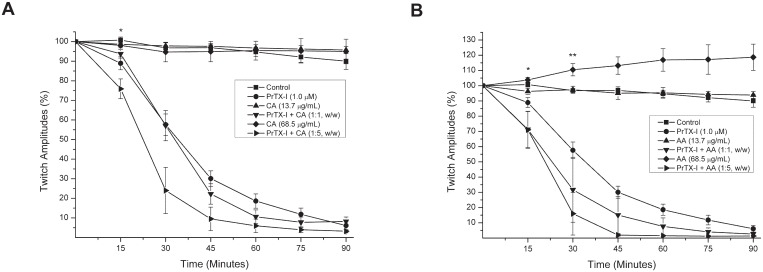
Effects of PrTX-I and PrTX-I pre-incubated with caffeicacid [CA](A) and aristolochicacid[AA] (B) on indirectly evoked twitches in mouse phrenic-diaphragm preparations.The ordinate represents the percentage amplitude of twitches relative to the initial amplitude. The abscissa indicates the time from the beginning of each treatment in the organ bath. The points are the mean ± S.E. * indicates the point at which differences between PrTX-I treatments (alone and pre-incubated with CA and AA) and the control become significant. ** indicates the point at which differences between AA (68.5 μg/mL) and the control become significant.